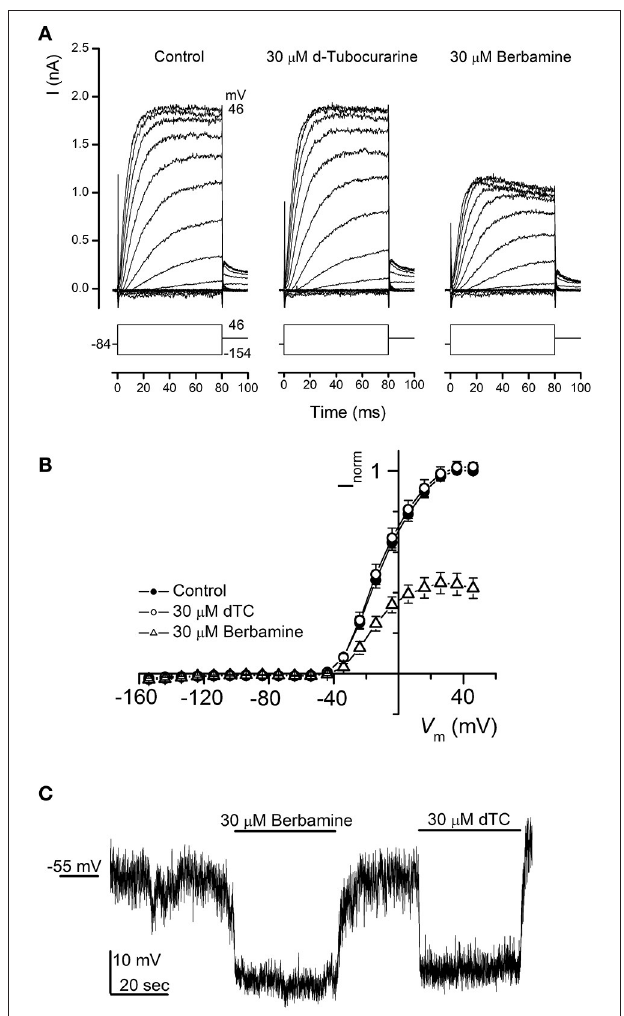
FIGURE 10 | Basolateral potassium currents are blocked by berbamine but not by d-tubocurarine. (A) Currents from an OHC recorded before and during exposure to 30 µ M dTC or berbamine reveal a decrease in current size during berbamine, but not dTC superfusion. Currents were recorded in response to 10 mV hyperpolarizing and depolarizing voltage steps from a holding potential of − 84 mV. Schematic representations of the voltage step protocols are shown below each trace. The leakage currents have been subtracted but the membrane potentials have not been adjusted for the residual series resistance (3.0 M (cid:127) ). The capacitance of the cell was 6.7 pF. (B) Average normalized steady-state I-V curves for all cells before (closed symbols; n = 12) and during exposure to 30 µ M dTC (open circles; n = 9) or 30 µ M berbamine (open triangles; n = 8). (C) Monitoring membrane potential changes under current clamp revealed that exposure to both 30 µ M berbamine and 30 µ M dTC resulted in a hyperpolarization of the cell of more than 10 mV from the resting potential of − 55